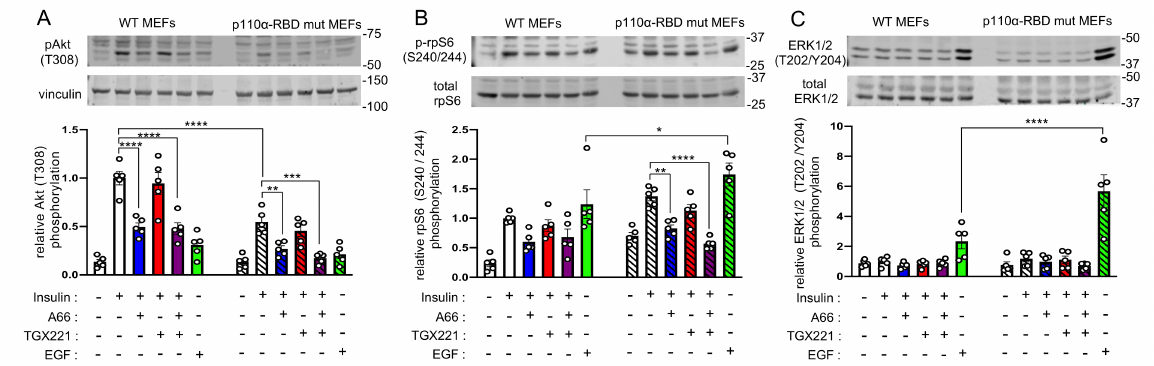
Figure 3. p110 α maximal activation by insulin requires interaction with Ras. Wild-type (non-striped graph bars) and mutant (striped graph bars) p110 α -RBD MEFs were treated with A66 (1 µ M, blue graph bars) or TGX221 (0.5 µ M, red graph bars) or a combination of both inhibitors (purple graph bars) followed by stimulation with 100 nM of insulin or with 15.6 nM of EGF (green graph bars) for 15 min at 37 ◦ C. ( A ) Levels of Akt (T308) phosphorylation were determined by immunoblot analysis. Phosphorylation levels were normalised to vinculin used as a loading control. rpS6 (S240/244) phosphorylation ( B ) and ERK1/2 (T202/Y204) phosphorylation ( C ) were also detected in the same immunoblots. Representative immunoblots and corresponding bar graphs with pooled data from five ( n = 5) independent experiments are shown. Data are presented as mean ± SEM. Statistical analysis was performed by two-way ANOVA with Dunnett’s multiple comparisons test between insulin-stimulated vehicle-treated and insulin-stimulated inhibitor-treated samples of the same genotype or Sidak’s multiple comparisons test between samples of different genotypes. * p < 0.05; ** p < 0.01; *** p < 0.001; **** p <